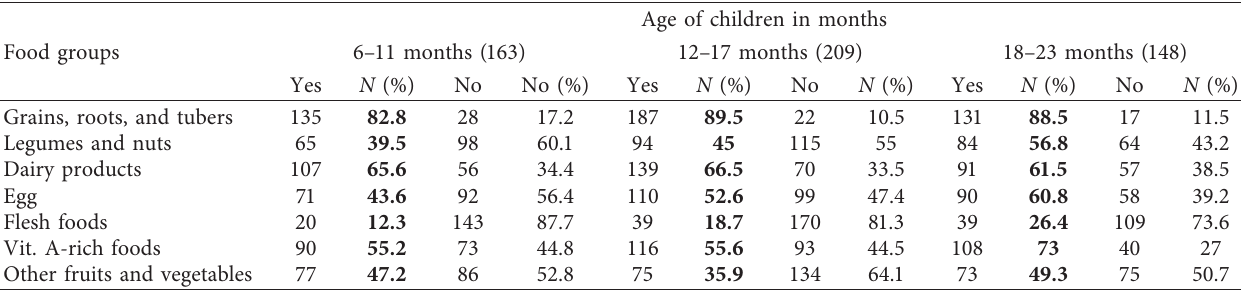
Figure 5: Household food security status among mothers of 6–23 months of age in Shashemene city, Oromia, Ethiopia, 2020. Note. Figure 5 indicates household food security status among mothers of 6–23-month children in Shashemene city. Table 3: Types of food groups given during the previous day according to the age of the child among children aged 6–23 months, Shashemene, 2020 ( n �